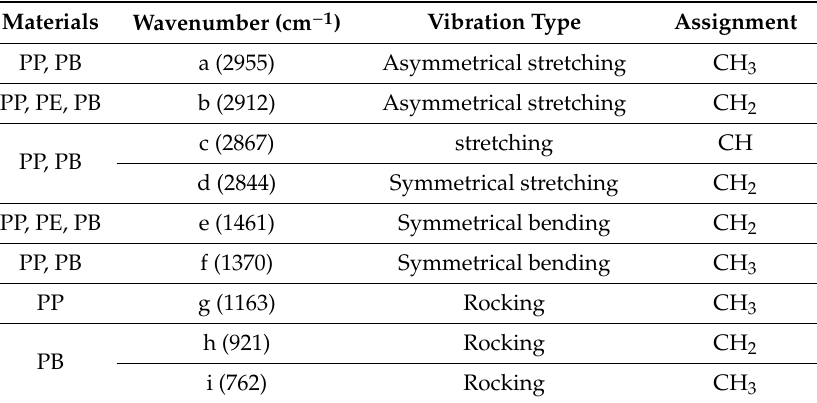
Table 2. IR spectra data of PP, PE and